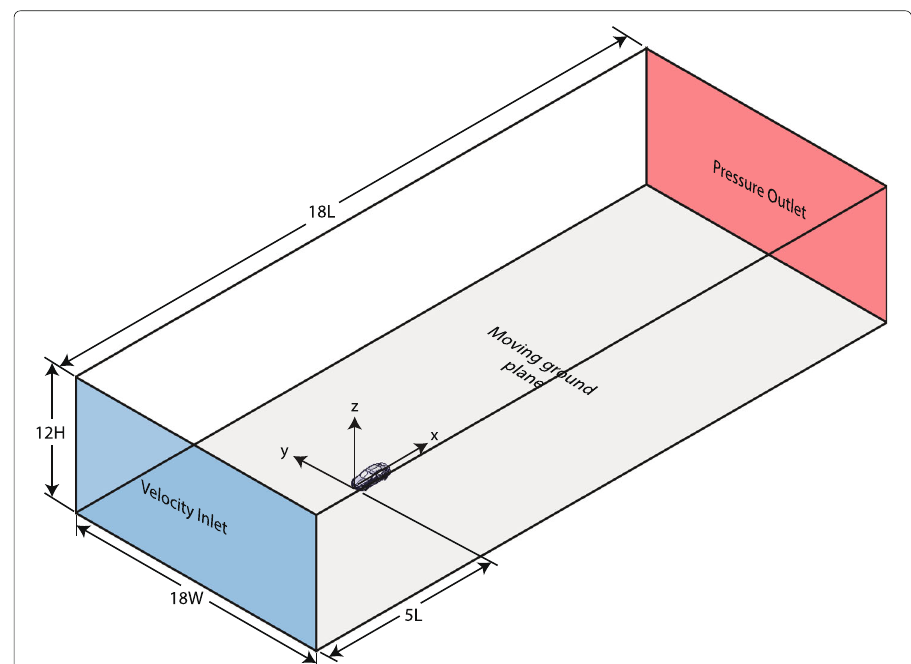
Fig. 6 Solution domain and boundary